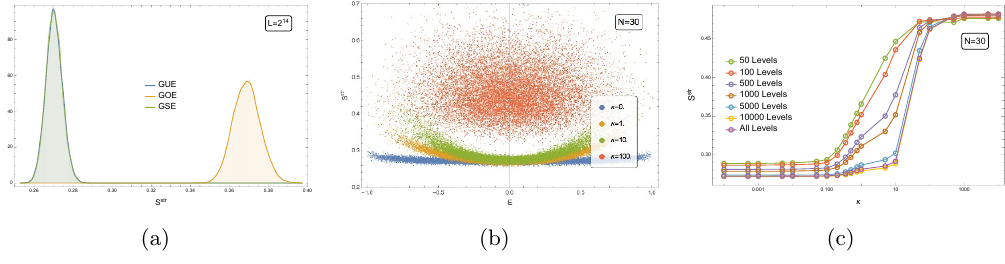
Figure 14 . (a) The distribution of the structural entropy of the GUE, GOE and GSE of dimension D = 2 14 . The distribution of the GUE and GSE overlap. The structural entropy of the GUE, GOE and GSE follows the Gaussian distribution with mean (cid:25) 0 : 270 ; 0 : 369 and 0 : 270 and deviation (cid:25) 0 : 00424 ; 0 : 00696 and 0 : 00416, respectively. (b) The distributions of the structural entropy of the even parity sector ( D = 2 14 ) of N = 30 SYK model with (cid:20) = 0 ; 1 ; 10 and 100 versus normalized energy E , respectively. (c) The mean value of the structural entropy of the subsectors of the spectra including L levels starting from the ground state of the even parity sector ( D = 2 14 ) of N = 30 SYK model versus (cid:20) .